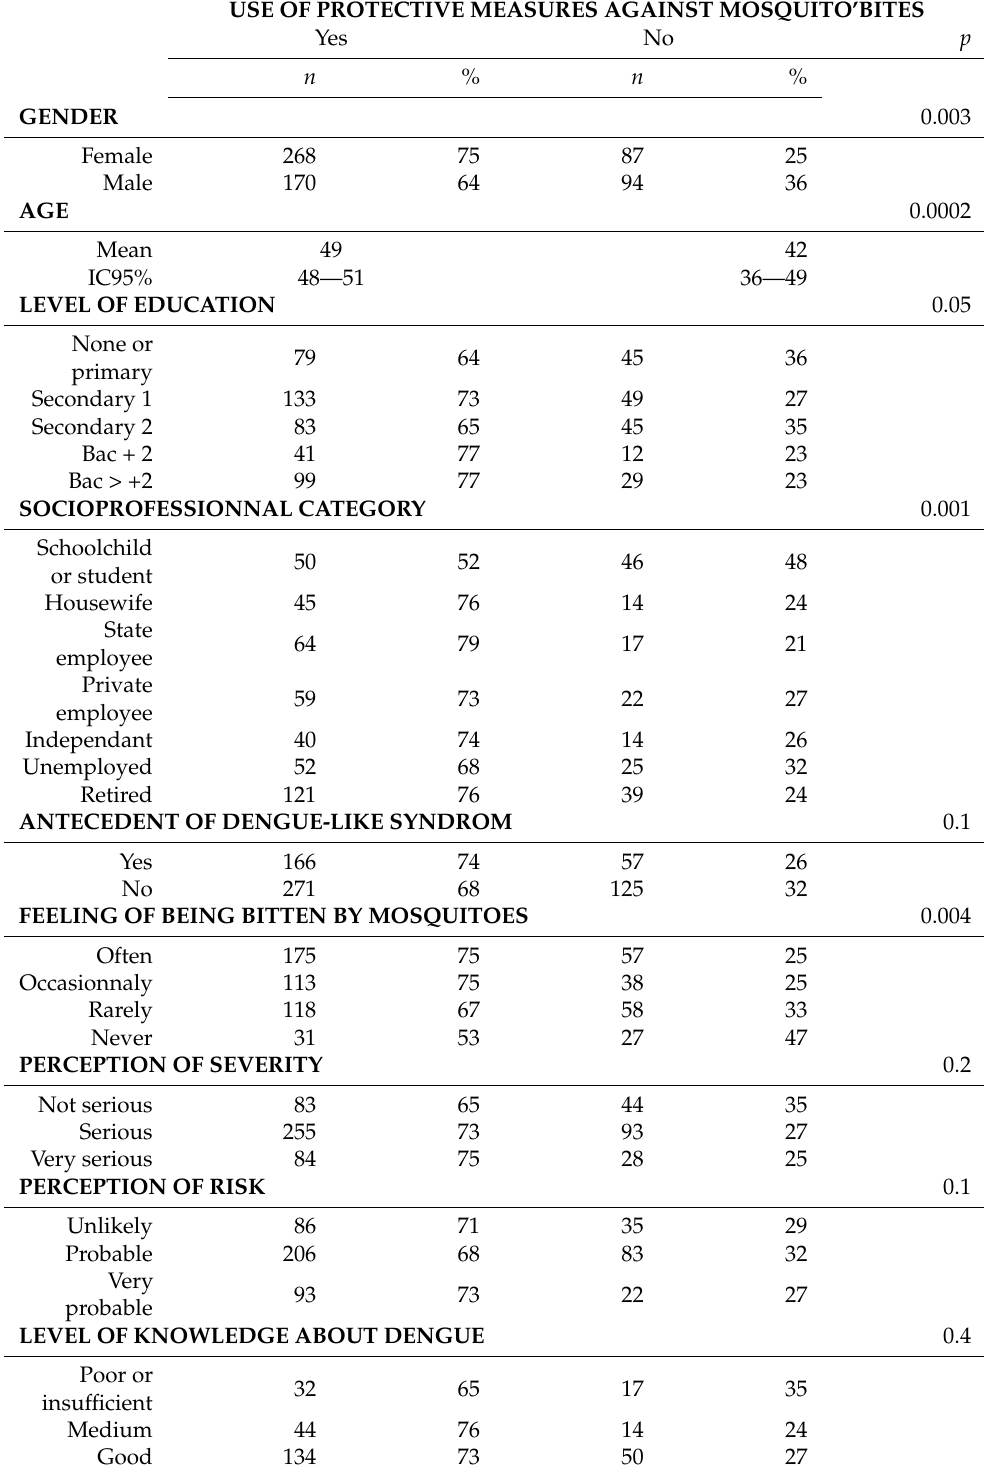
Table 4. Cross analysis between use of protective measures, socio-demographic characteristics, experience of a dengue-like symptoms, and perception of severity or risk. USE OF PROTECTIVE MEASURES AGAINST